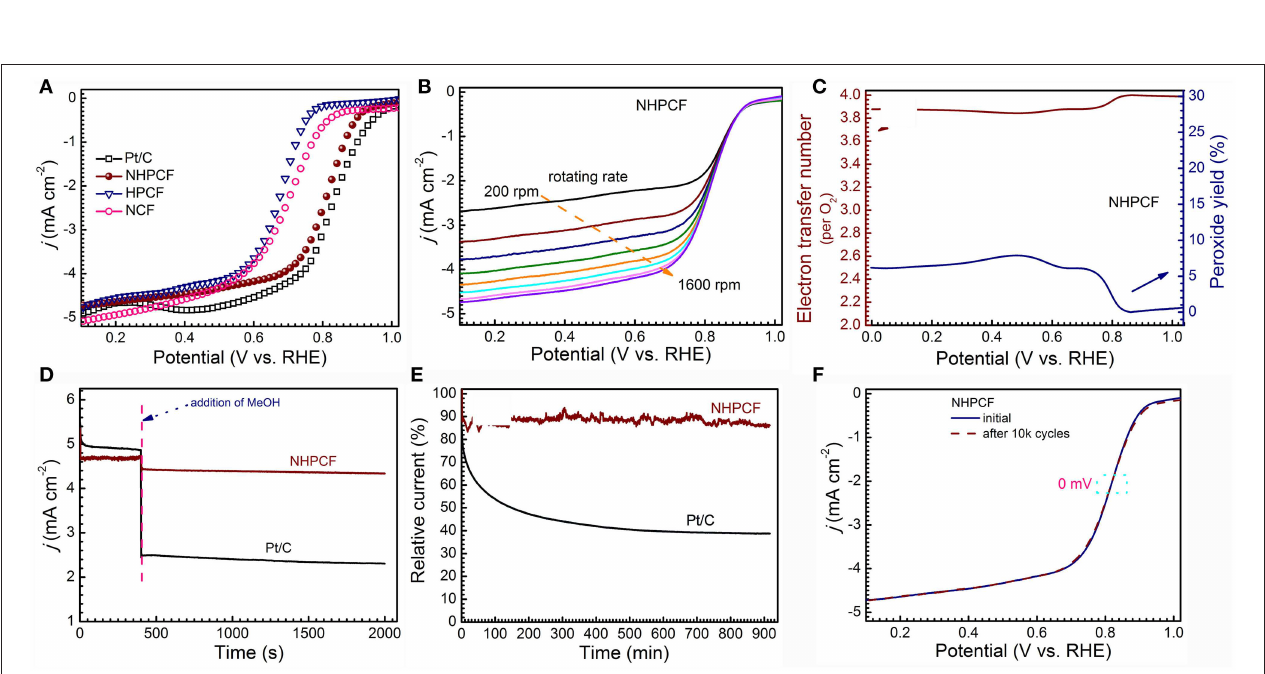
FIGURE 4 | (A) LSV curves of NCF, HPCF, NHPCF and Pt/C in O 2 -saturated 0.1M KOH at 1,600 rpm with 5 mV · s − 1 , (B) LSV curves of NHPCF with different rotate speed in O 2 -saturated 0.1M KOH, (C) the electron transfer number ( n ) and peroxide yield of NHPCF in O 2 -saturated 0.1M KOH at 1,600 rpm, (D) Tolerance tests of NHPCF and Pt/C in O 2 -saturated KOH (0.1M) with methanol (1M) at 1,600 rpm, (E) Chronoamperometry curves of NHPCF and Pt/C electrodes at 0.45V (vs. RHE) at 1,600 rpm and (F) Accelerated durability test (ADT) of NHPCF in O 2 -saturated 0.1M KOH.